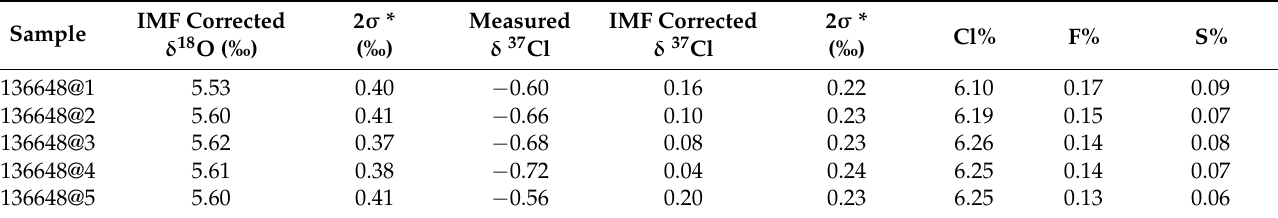
Table 4. Calibrated data of the seven apatite samples.